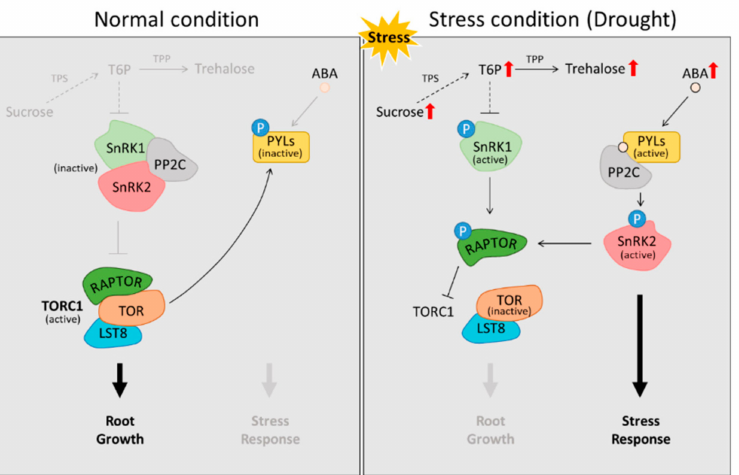
Figure 2. Metabolic regulation by trehalose and ABA against drought stress. The activation of SnRK1/2 by trehalose-6-phosphate and ABA breaks down the RAPTOR-TOR-LST8 complex and triggers a stress response. Drought tends to accumulate the level of soluble sugars in the roots (Red arrow) [65,66,71–74]. The LATERAL ORGAN BOUNDARIES DOMAIN transcription factors, LST8; PP2C, Protein phosphatase 2C; PYL, pyrabactin resistance-like; RAPTOR, REGULATORY- ASSOCIATED PROTEIN OF TOR; SnRKs, SNF1-RELATED KINASE; T6P, Trehalose-6-phosphate; TOR, TARGET OF RAPAMYCIN; TPP, T6P-phosphatase; TPPE, Probable trehalose-phosphate phos- phatase E; TPS, trehalose-6-phosphate